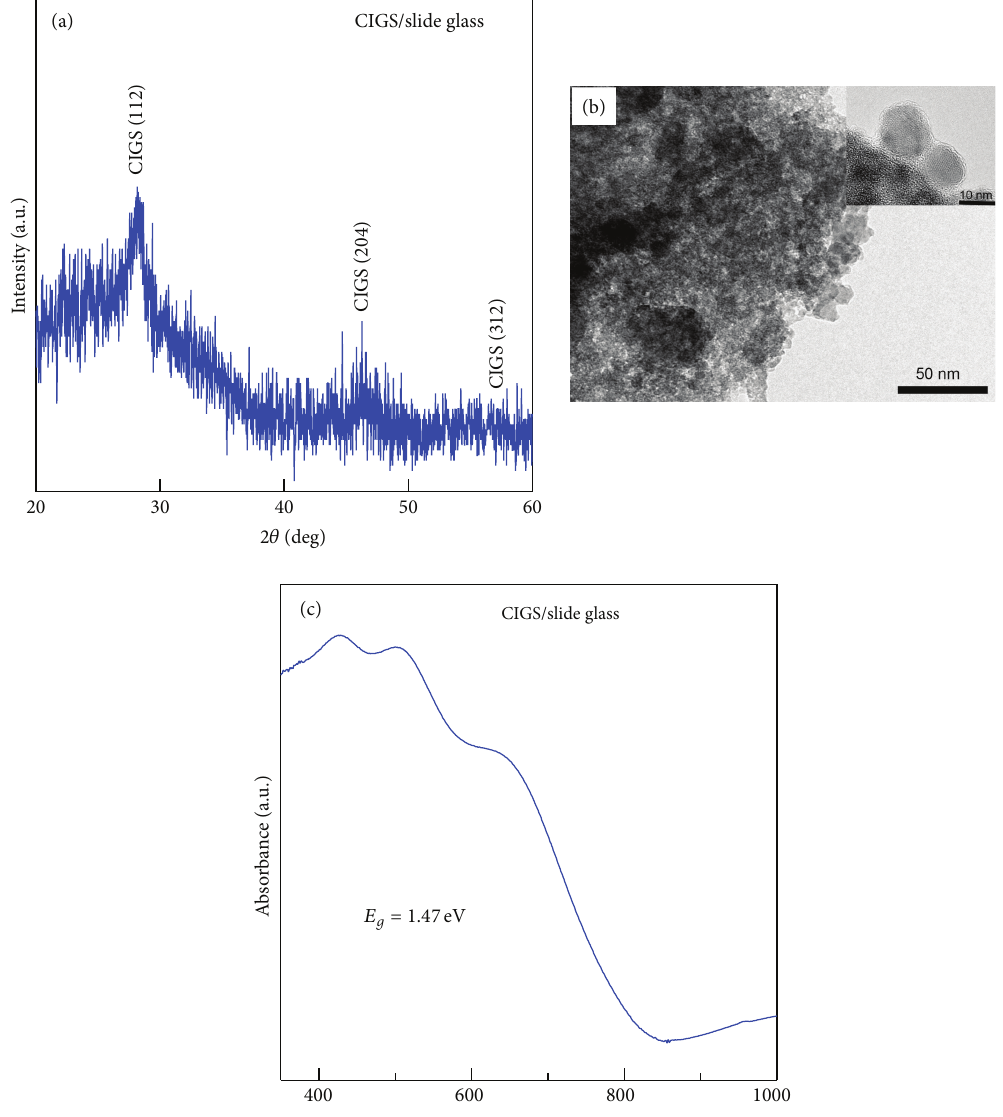
Figure 1: XRD pattern (a) and absorption spectrum (c) of CIGS nanoparticles coated on slide glass and TEM images of CIGS nanoparticles (b). The inset in (b) is a high-magnification TEM image of CIGS nanoparticles.